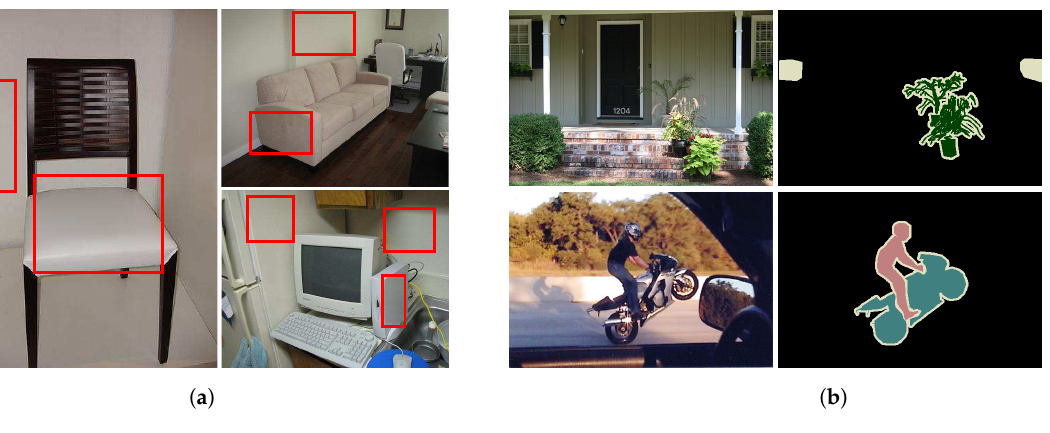
Figure 1. An example in the PASCAL VOC 2012 dataset. ( a ) Chairs, sofas, and optical modems in the field of interest have the same color and shape as the walls and wardrobes in the background. ( b ) Areas of interest only occupy an unobtrusive part of the whole picture.